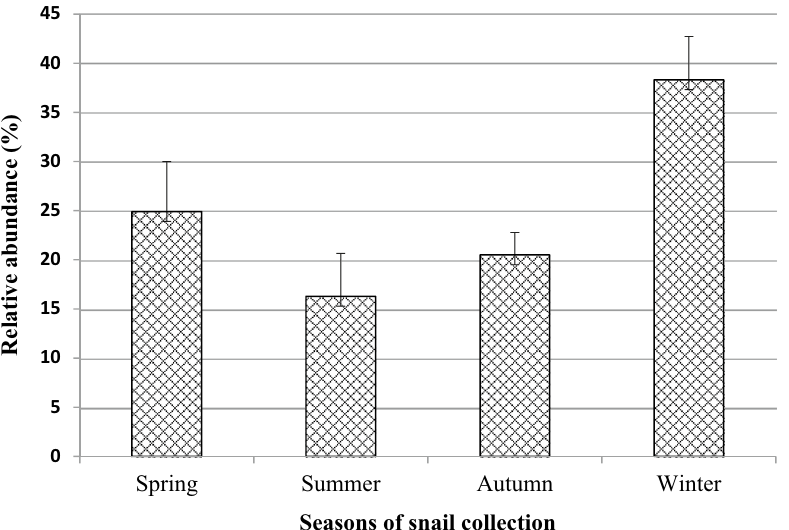
Figure 5. Relative abundance of Biomphalaria snails on a seasonal basis.